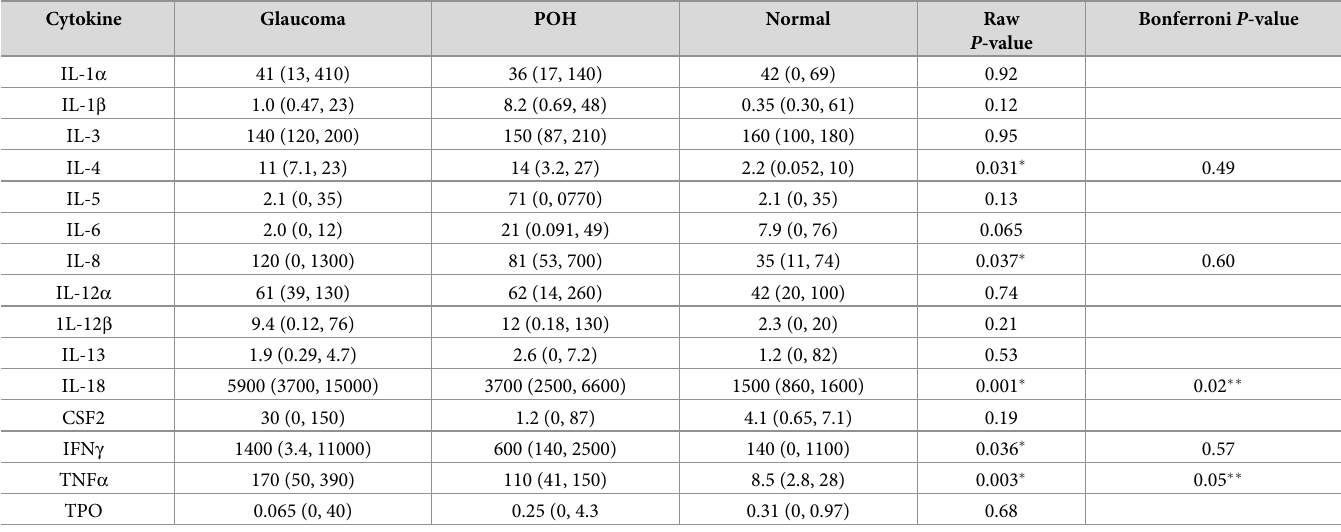
Table 3. Pro-inflammatory cytokine levels for all groups.